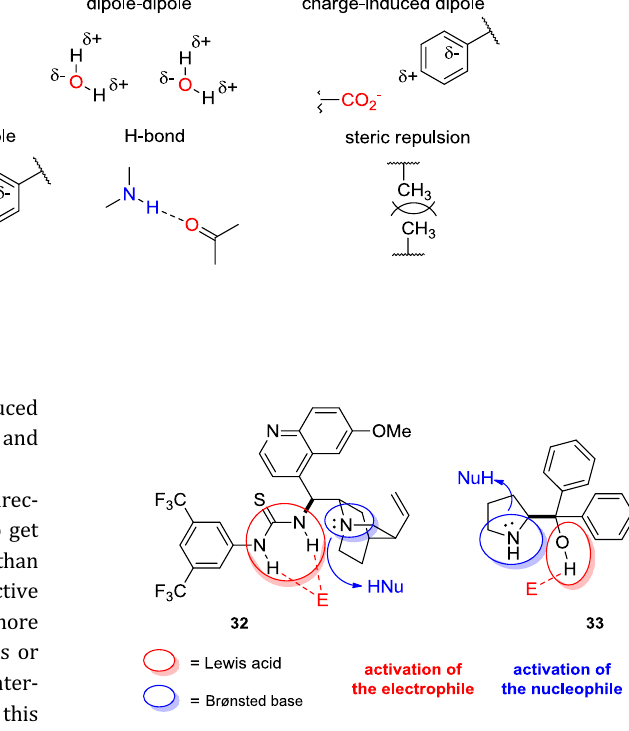
Figure 10. Examples of bifunctional, non-covalent